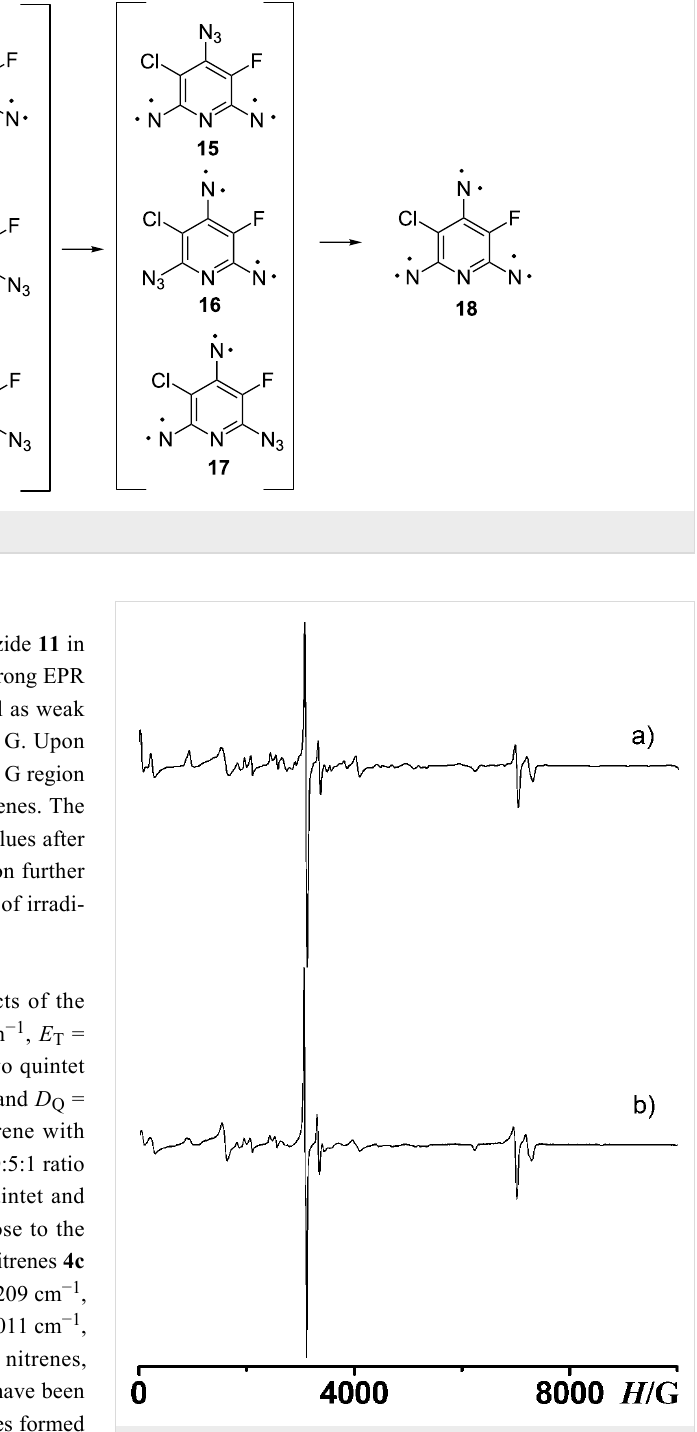
Figure 1: EPR spectra: (a) simulated spectrum for a mixture of five nitrenes with (i) S = 1, g = 2.003, D T = 1.026 cm − 1 and E T = 0; (ii) S = 1, g = 2.003, D T = 1.122 cm − 1 and E T = 0.0018 cm − 1 ; (iii) S = 2, g = 2.003, D Q = 0.209 cm − 1 , E Q = 0.039 cm − 1 ; (iv) S = 2, g = 2.003, D Q = 0.215 cm − 1 , E Q = 0.0545 cm − 1 ; (v) S = 3, g = 2.003, D S = –0.1021 cm − 1 , E S = –0.0034 cm − 1 in a 14:12:20:5:1 ratio; (b) experi- mental spectrum after 45 min of UV irradiation of triazide 11 . Microwave frequency ν 0 = 9.605832